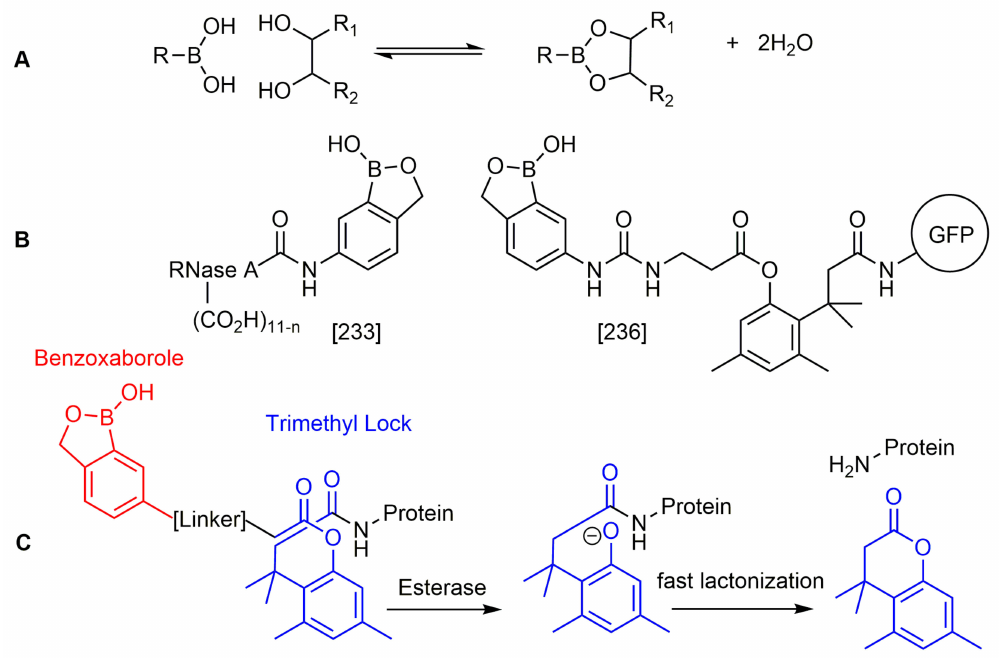
Figure 5. ( A ) Boronic acids bind to 1,2 and 1,3 diols on carbohydrates forming a cyclic boronic ester. ( B ) Benzoxaborole-modified proteins as a delivery mechanism to transport proteins into cell. RNaseA [217] and green fluorescent protein (GFP) [220] were used as proof of concept. ( C ) Benzoxaborole-trimethyl lock protein shuttling mechanism. Benzoxaborole binds to